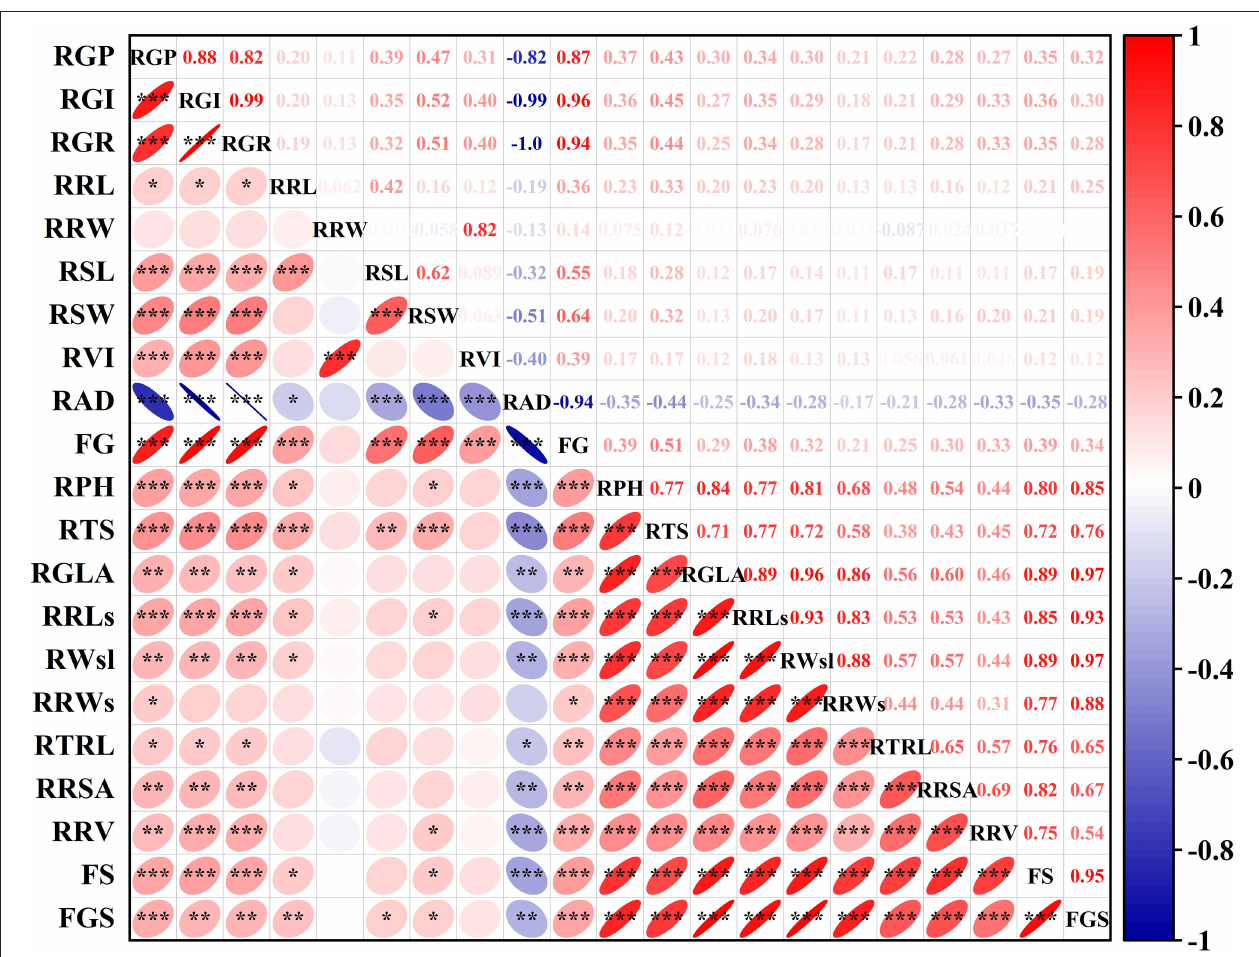
FIGURE 3 | PCA of all traits from 111 genotypes at germination stage and seedling stage. PCA, Principal component analysis. RGP, relative germination potential; RGI, relative germination index; RGR, relative germination rate; RRL, relative root length at germination; RRW, relative root fresh weight at germination; RSL, relative sprout length; RSW, relative fresh sprout weight; RVI, relative vigor index; RAD, relative alkali damage rate; FG, F -value at germination stage; RPH, relative plant height; RTS, relative stem thickness; RGLA, relative green leaf area; RRLs, relative root length at seedling; RWsl, relative stem and leaf fresh weight; RRWs, relative root fresh weight; RTRL, relative total root length; RRSA, relative root surface area; RRV, relative root volume; FS, F -value at the seedling stage; FGS, comprehensive F -value at germination and seedling stage. * P < 0.05; ** P < 0.01;*** P <